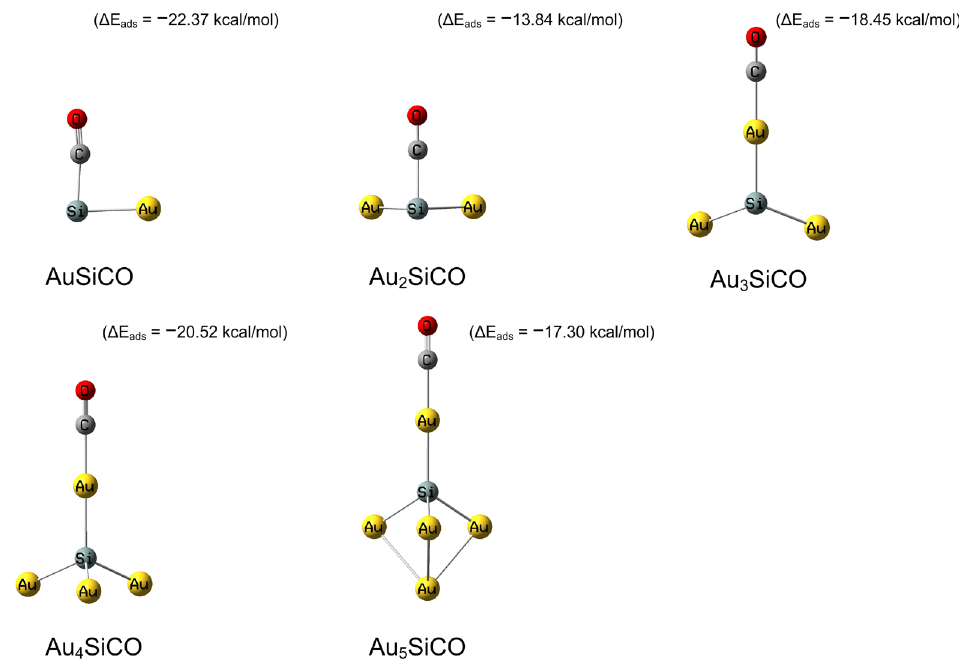
Figure 1. Optimized lowest-energy geometries of CO adsorbed with SiAu n ( n = 1–5) and the corre- sponding adsorption energies at the CAM-B3LYP/aug-cc-pVDZ-PP level of theory (in